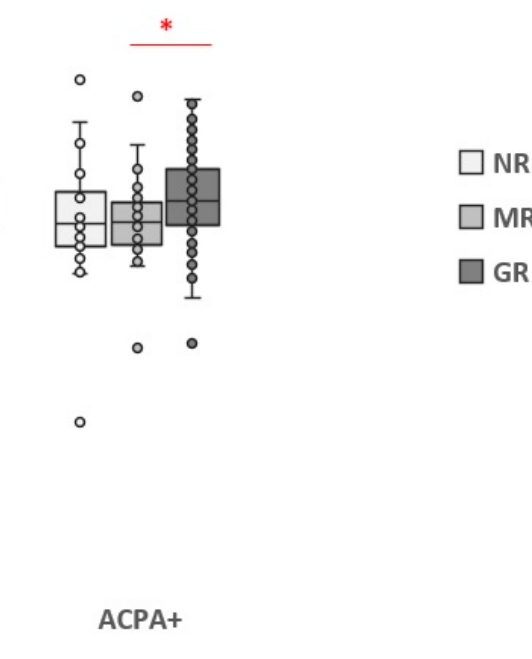
Figure 3. Association of LINE-1 methylation level with response to the therapy stratified by ACPA positivity. Data are presented as the average methylation percentage of five CpG sites. NR, No Response; MR, Moderate Response; GR, Good Response; * significant nominal p -value.